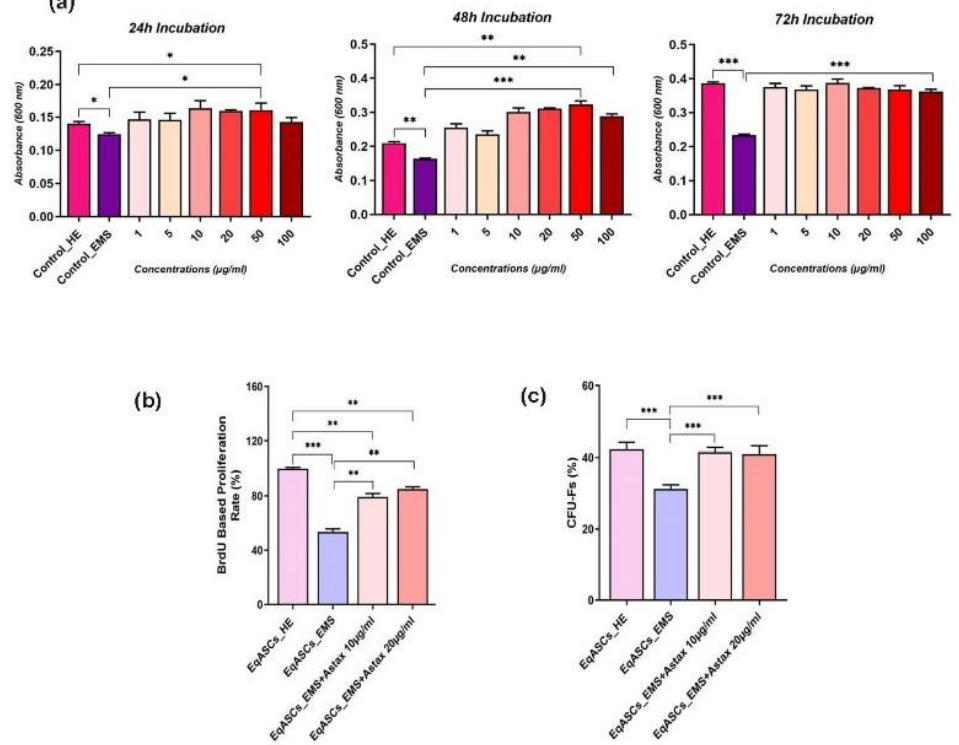
Figure 1. Impact of astaxanthin on cell proliferation. ( a ) The average absorbance at 600 nm after 24 h, 48 h, and 72 h of metabolized resazurin dye by healthy, treated, and untreated cells are shown by histograms. ( b ) Percentage of incorporated BrdU in newly synthetized DNA. ( c ) Cell proliferation assay using the clonogenic fibroblast precursor (CFU-F) assay. A comparison of EMS, treatment groups and untreated healthy cells is shown by an asterisk (*). * p < 0.05, ** p < 0.01, *** p < 0.001 .